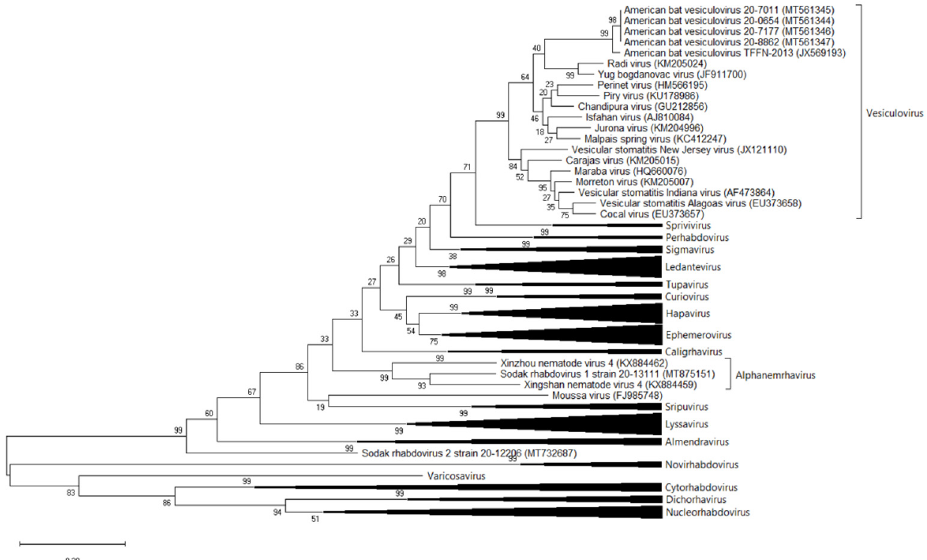
Figure 2. Phylogenetic analysis of conserved blocks of the L protein of Rhabdoviridae . Sequences were aligned by MUSCLE, and the phylogenetic tree was inferred by maximum likelihood analysis using the Whelan and Goldman model using a single set of stationary frequencies as implemented in MEGAX. Tree topology was verified with 500 bootstrap replicates.